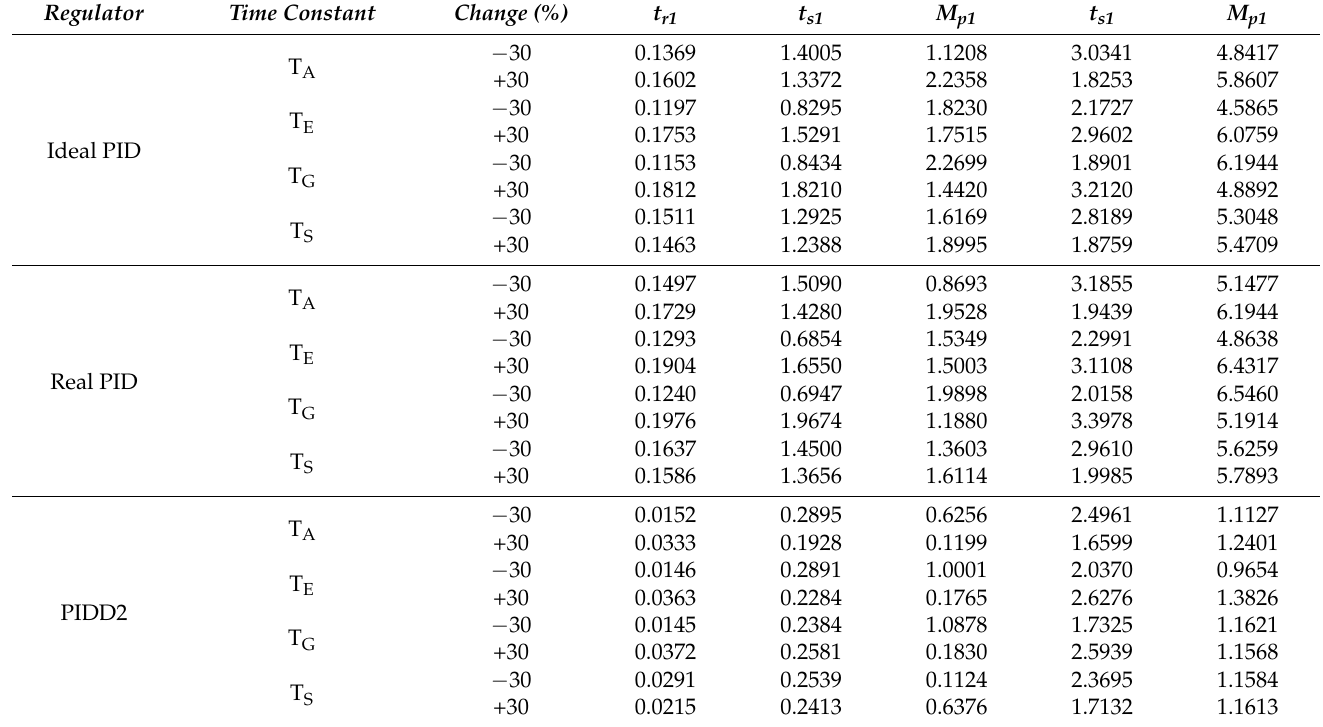
Table 4. Transient response of the regulators investigated, robustness analysis.